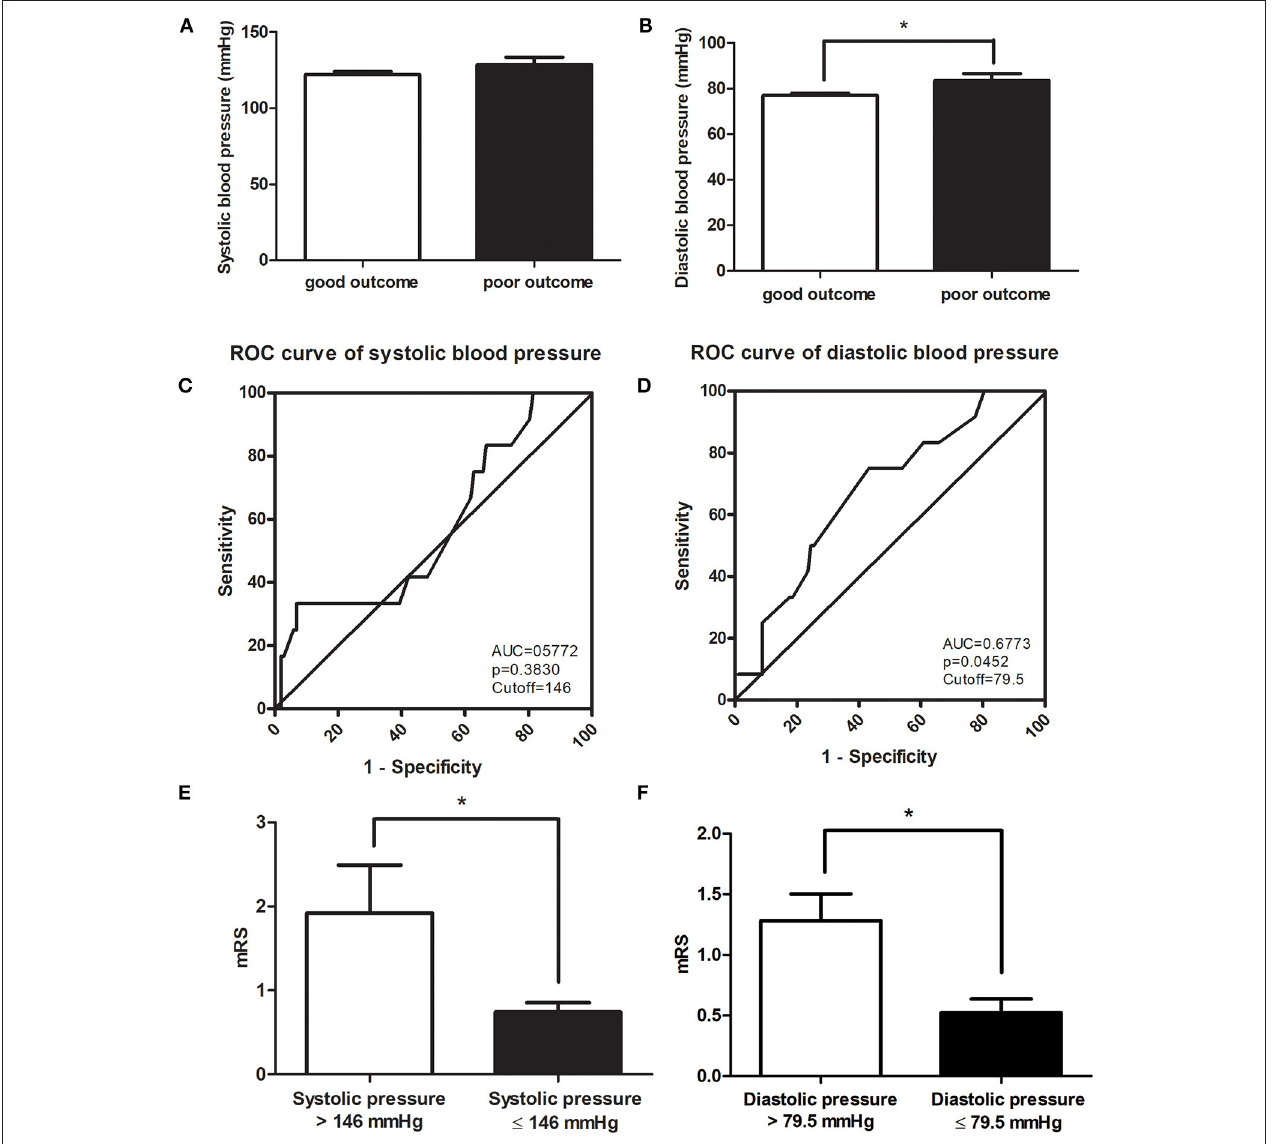
FIGURE 3 | No significant difference was found in SBP between CVT patients with good prognosis and those with poor prognosis (A) . DBP in CVT patients with good prognosis was significantly lower than in those with poor prognosis (B) . A volume of 146 mmHg of SBP as a cutoff value exhibited low sensitivity and specificity (C) whereas DBP < 79.5 mmHg predicted a good clinical outcome with high sensitivity and specificity (D) . CVT patients with SBP > 146 (E) or DBP > 79.5 mmHg (F) had significantly higher mRS compared to those with SBP ≤ 146 mmHg (E) or DBP ≤ 79.5 mmHg (F) . * p <